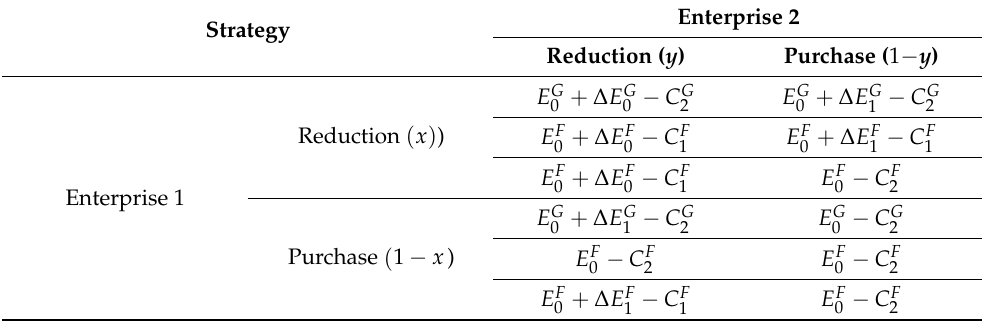
Table 6. Tripartite evolutionary game payoff matrix without government